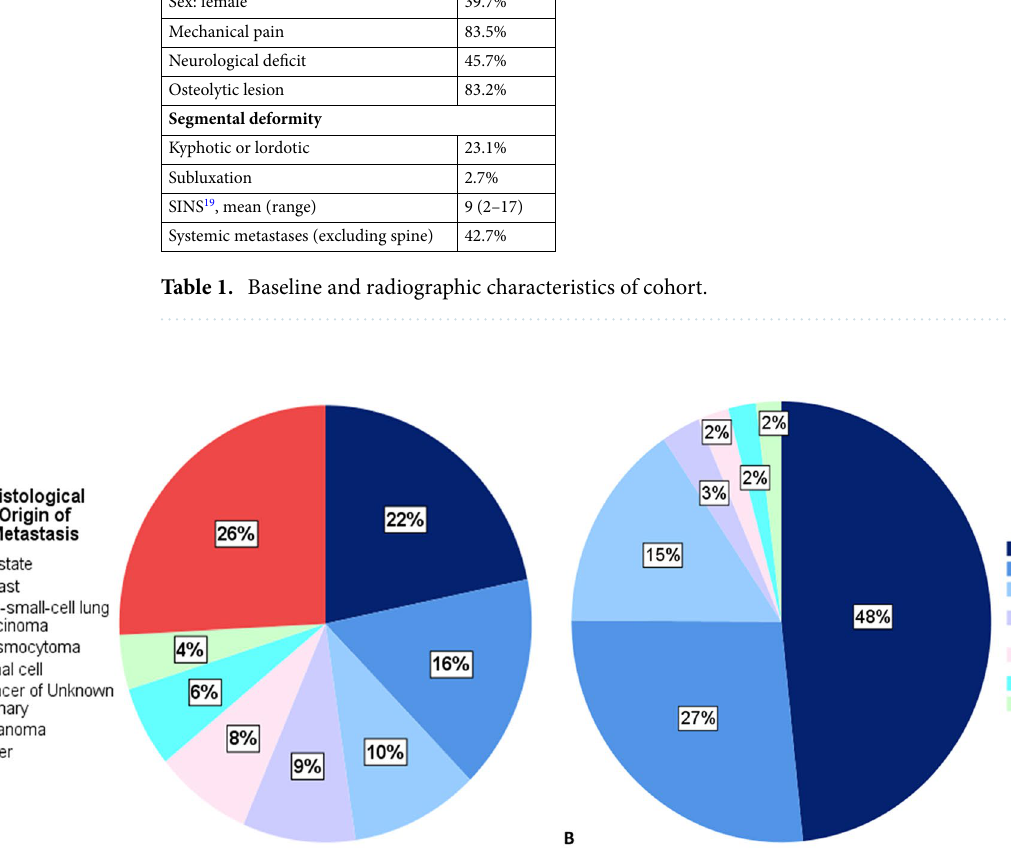
Figure 1. Distributions of primary cancer origin (A) and localization in the spine (B) . Other—colorectal, pharynx, hepatocellular, uterus, pancreas, sarcoma, lymphoma, gastric, urothelial, thyroid, testicular, parotid, small-cell lung, adrenal, duodenal,